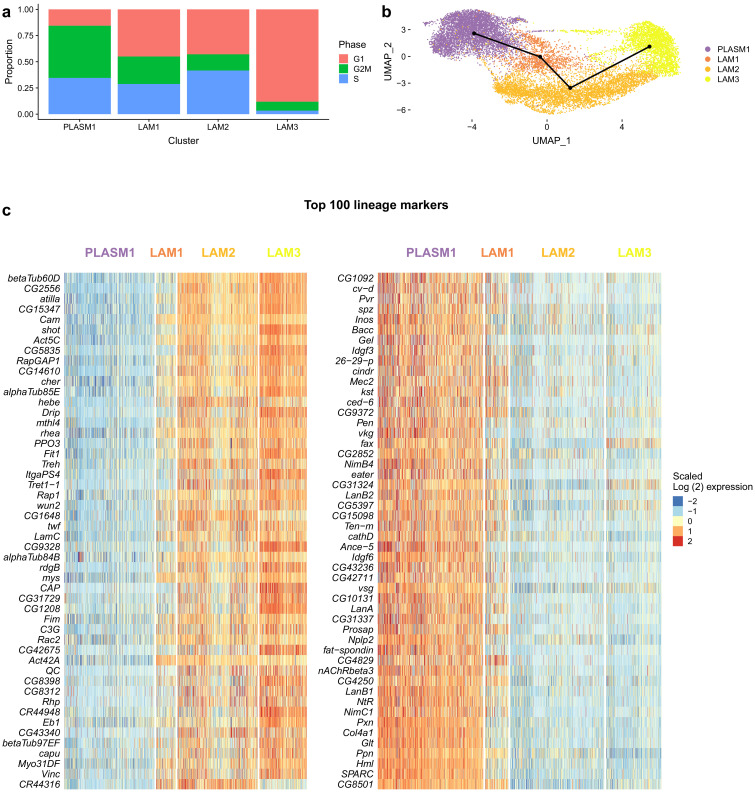
Trajectory of lamellocyte differentiation following subclustering.(A) Proportions of cells in G1, G2M, and S phase in the plasmatocyte progenitor and lamellocyte clusters. (B) Trajectory of lamellocyte differentiation inferred following cell cycle correction and regressing out the difference between the G2M and S phases. Trajectories were inferred from multi-dimensional principle components analysis, and the lineage projected onto the two-dimensional UMAP plot. (C) Heatmap of top 100 markers predicting lamellocyte differentiation as ranked by variable importance. Genes are grouped by mean cluster expression level and cells (columns) were ordered by expression of the 101st marker. Log2-fold change gene expression levels were centered on their mean value and divided by their standard deviation.